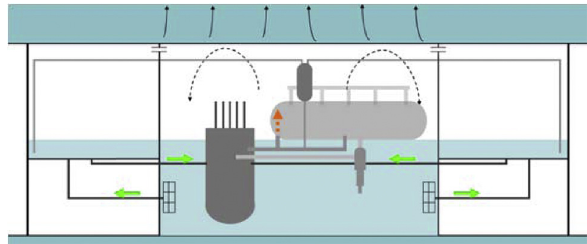
Fig. 4. Targeted safe state when primary circuit has